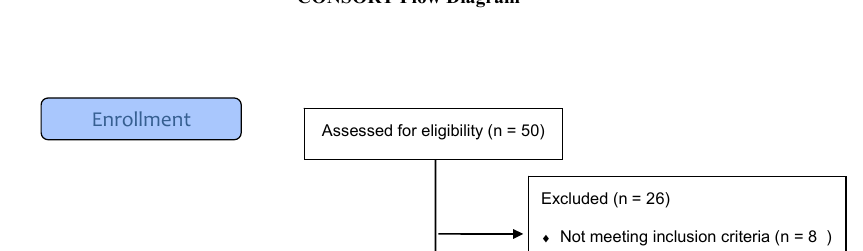
Figure 1. CONSORT patient flow diagram. n = number.